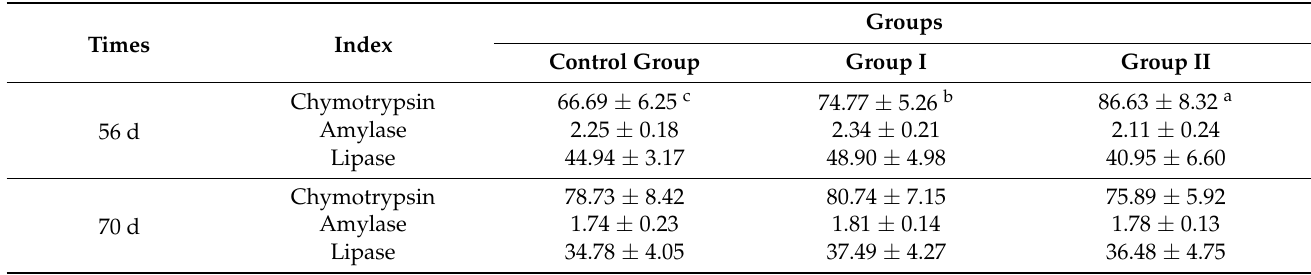
Table 6. Effects of feed restriction and compensation on digestive enzyme activities in rab- bits (U/gprot).